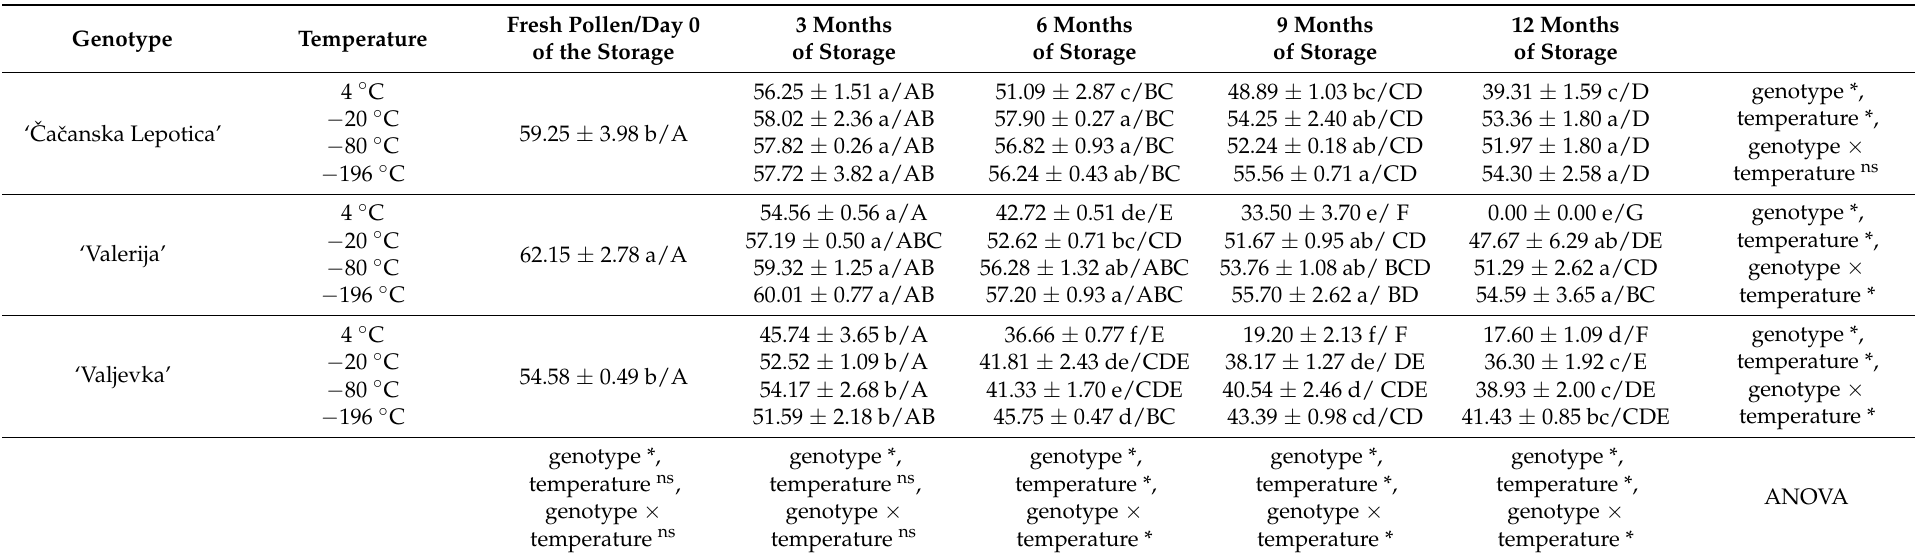
Table 3. Viability (FDA staining) of pollen grain stored at different temperatures for different